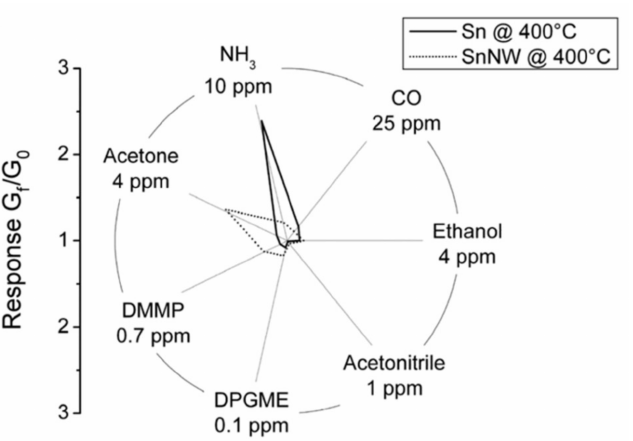
Figure 5. Surface termination effects in nanowire- and nanoparticle-based chemiresistors. Polar plot comparing the response of SnO 2 nanowires (SnNW) and nanoparticles (Sn) against different chemicals. © 2008 IEEE. Reprinted, with permission, from